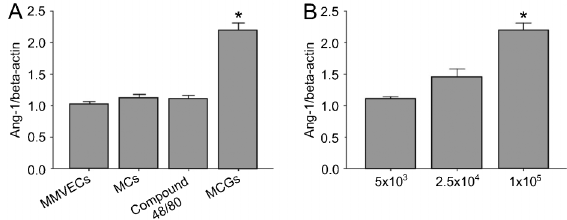
Figure 1. Effect of MCs activation on Ang-1 mRNA levels in co- culture of MMVECs. A , MMVECs were cultured with nonactivated MCs, compound 48/80 and activated MCs. B , MCGs correspond- ing to 5 6 10 3 , 2.5 6 10 4 , and 1 6 10 5 MCs were added to MMVECs. Data are reported as means±SE (n=3). MCs: mast cells; Ang-1: angiopoietin; MMVECs: myocardial microvascular endothelial cells; MCGs: MC granules. *P , 0.05, Student- Newman-Keuls